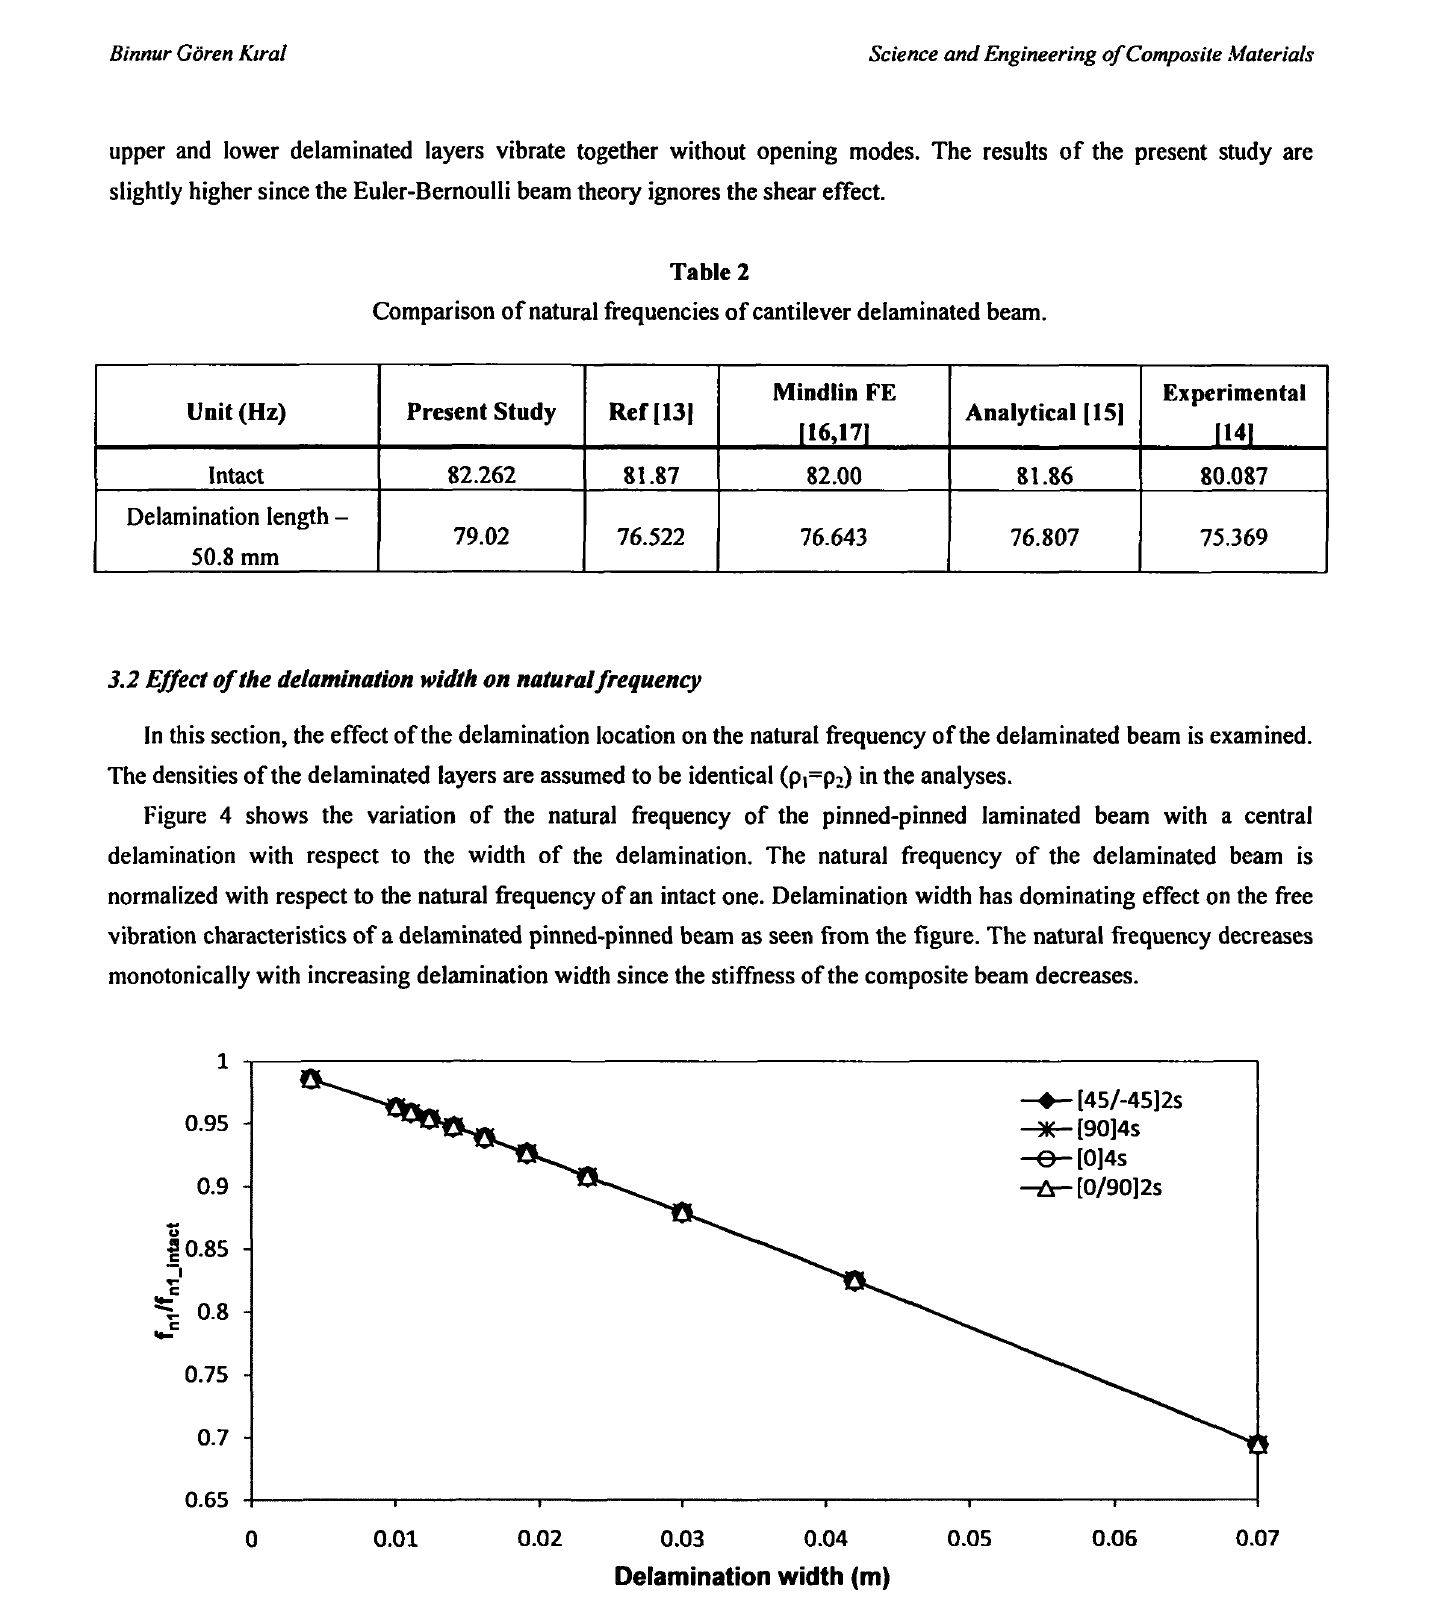
Fig. 4: Effect of the delamination width on the normalized first natural frequency of the pinned-pinned beam